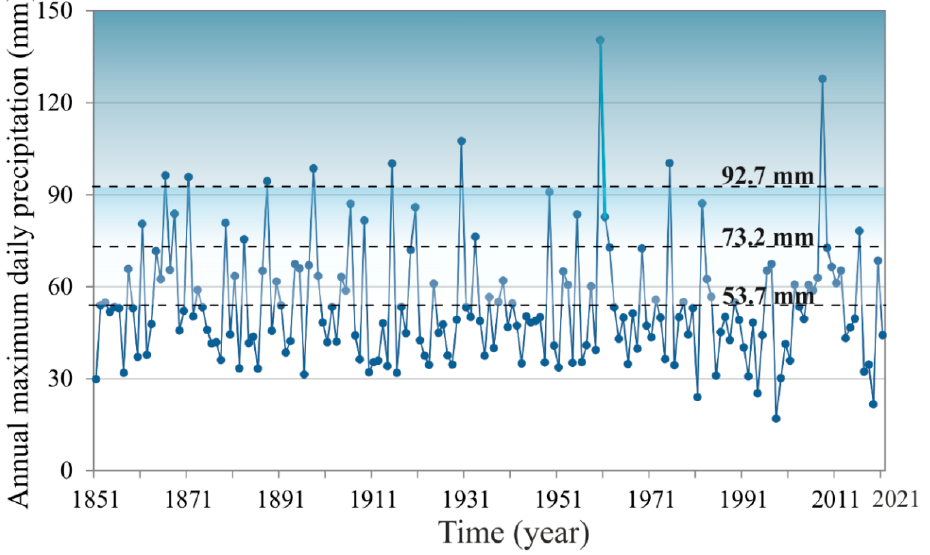
Figure 2. Temporal evolution of the annual maximum daily precipitation ( P MD ) compared with the estimated risk values ( R L = 53.7 mm, R H = 73.2 mm and R D = 92.7 mm).